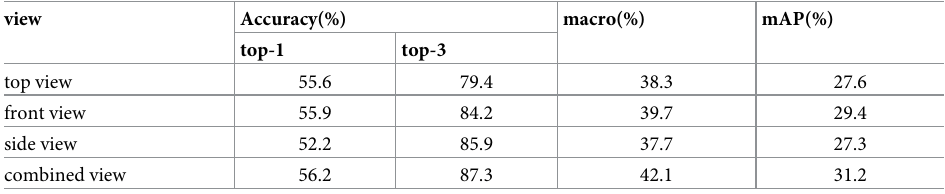
Table 7. Compositional action recognition of different views based on IKEA ASM dataset.